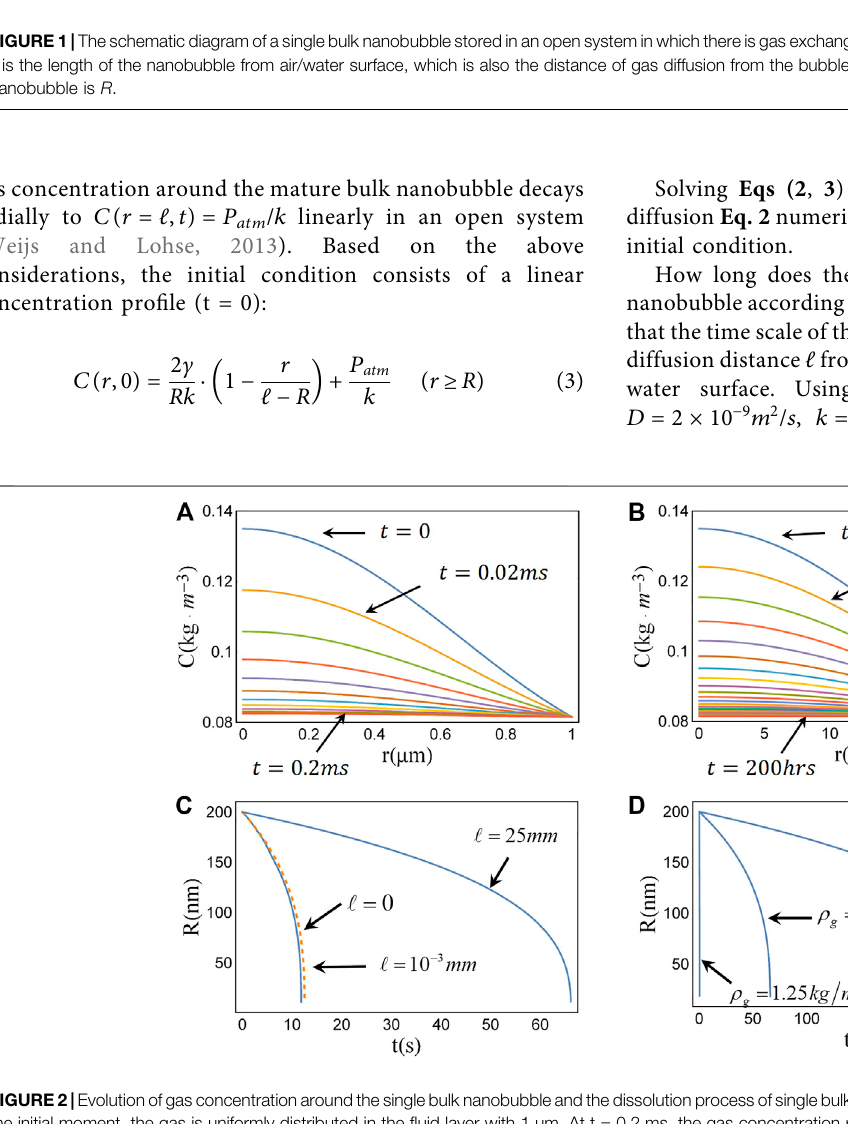
Frontiers in Materials |